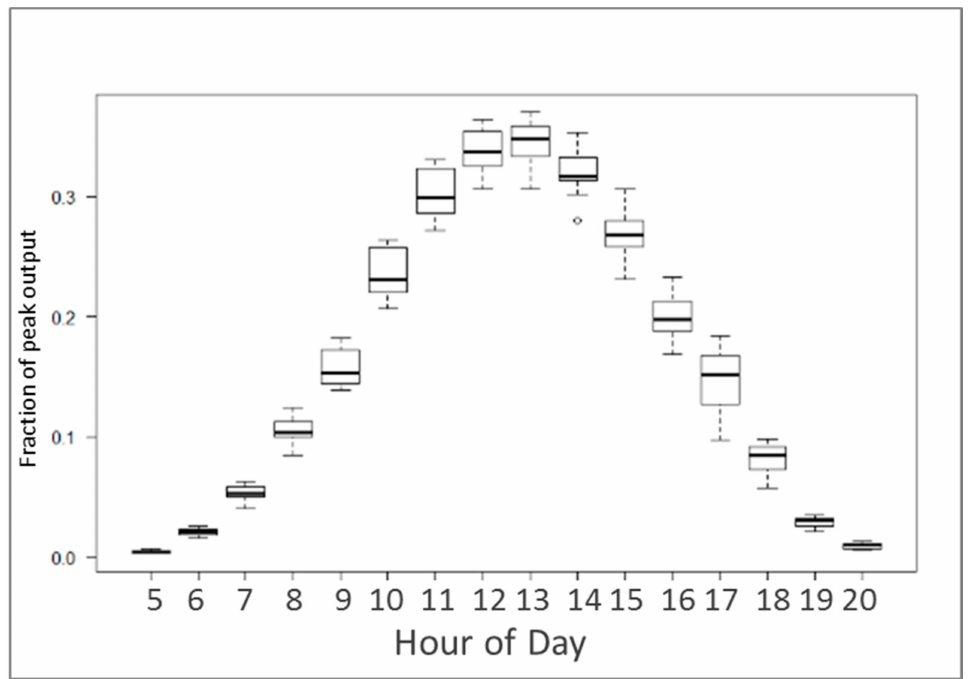
Figure 14. Boxplots illustrating Variability of average hourly fraction of peak output (5: 00 am–8: 00 pm) for each DNO